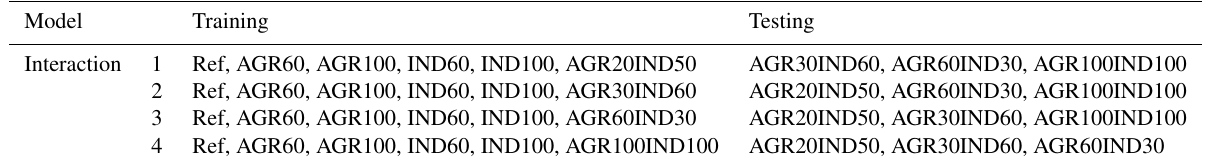
Table 3. List of CTM sensitivity simulations used to select the optimal scenario by training and testing the various combinations to account for interactions in the quadratic forms of the surrogate model.